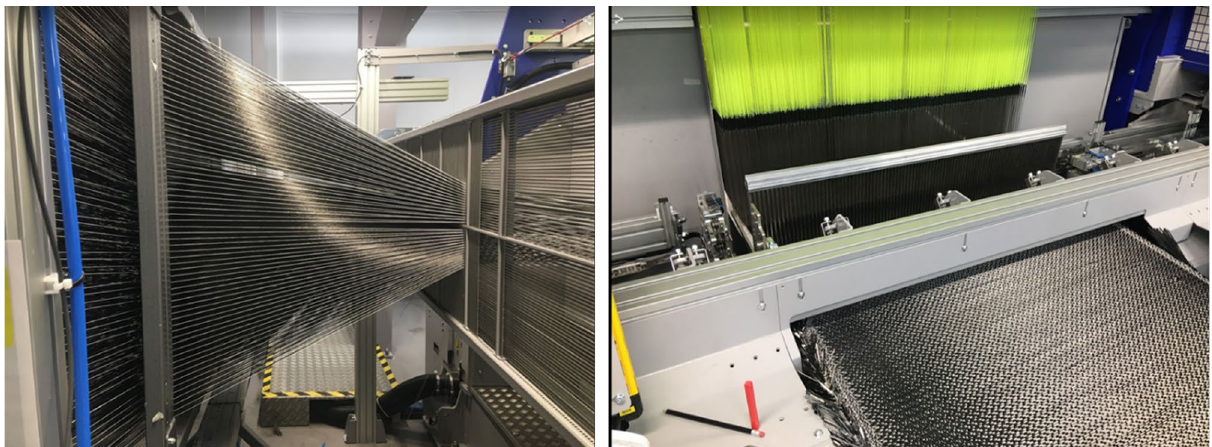
Figure 6. The 3D weaving machine in operation with fibres loaded at the back (left) and fabric produced at the front (right) of the